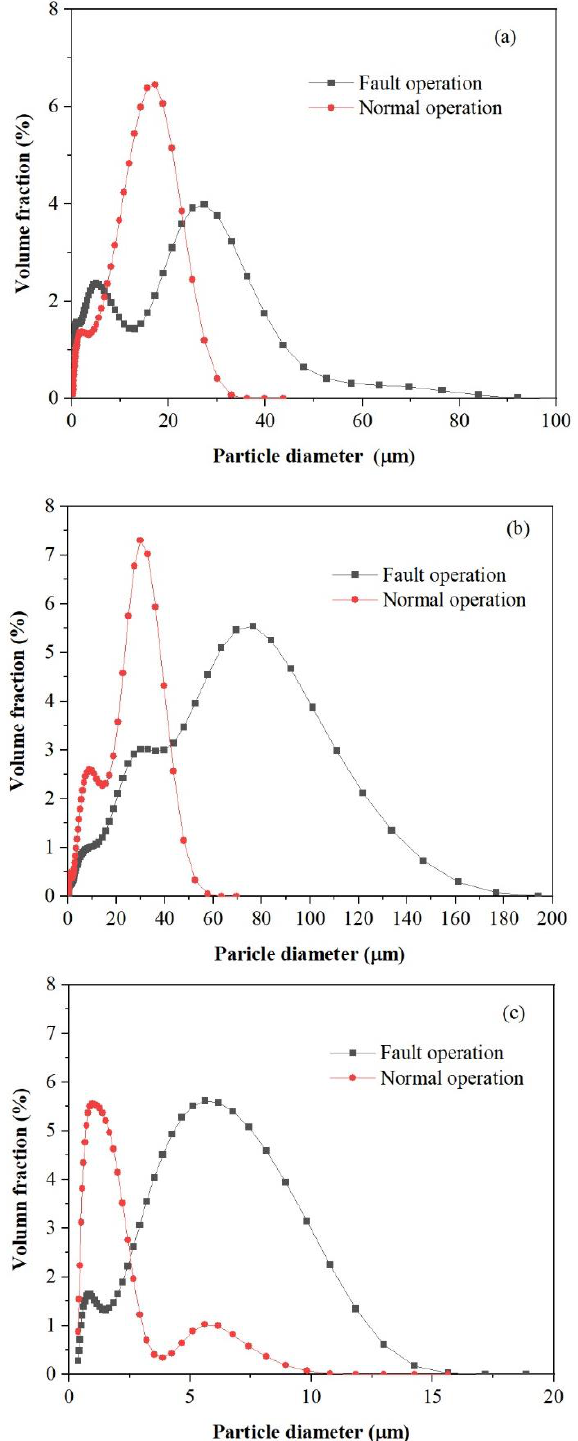
Figure 9. PSD of catalyst particles ( a ) in the TSS inlet pipeline, ( b ) in the TSS hopper, and ( c ) in the TSS outlet pipeline.